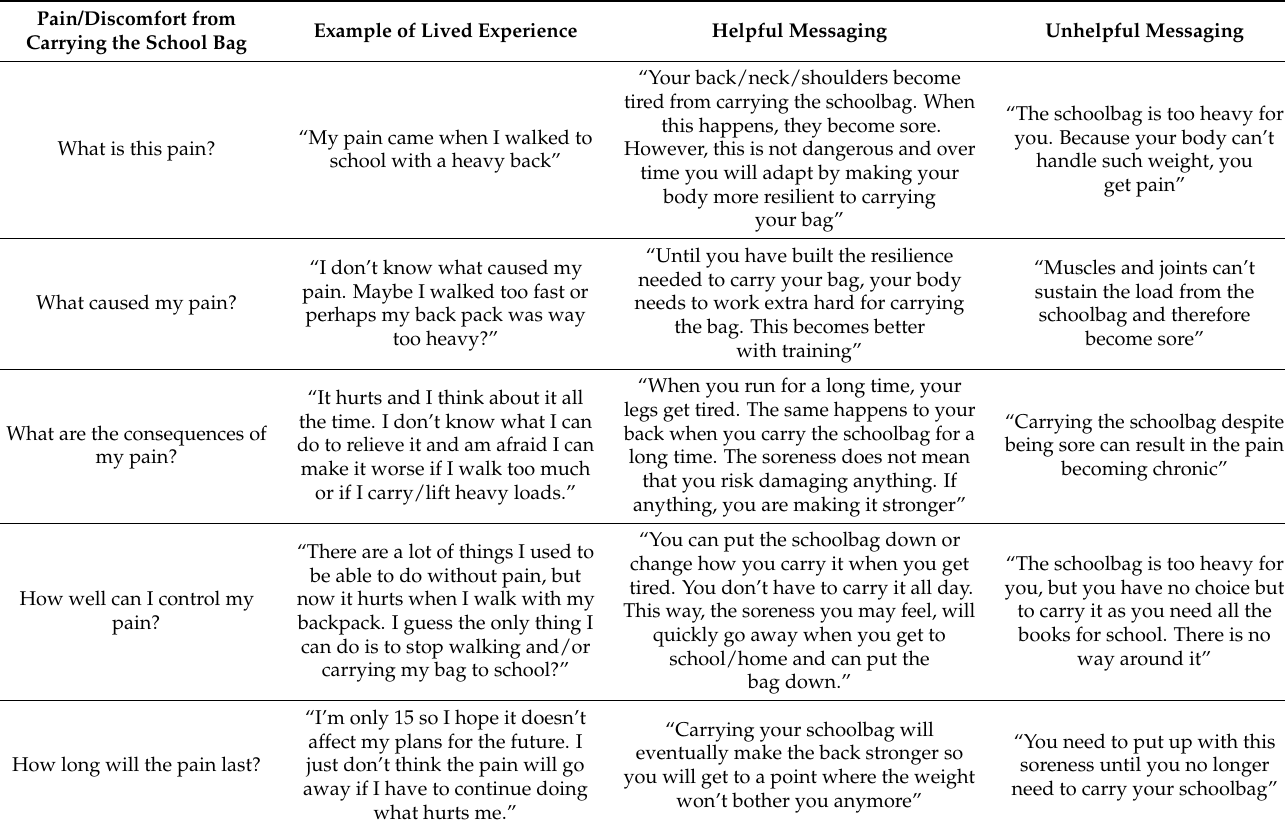
Table 2. An example of how the Common Sense Model can be used as a part of the assessment and management, if indicated by assessment findings. Pain/Discomfort from Carrying the School